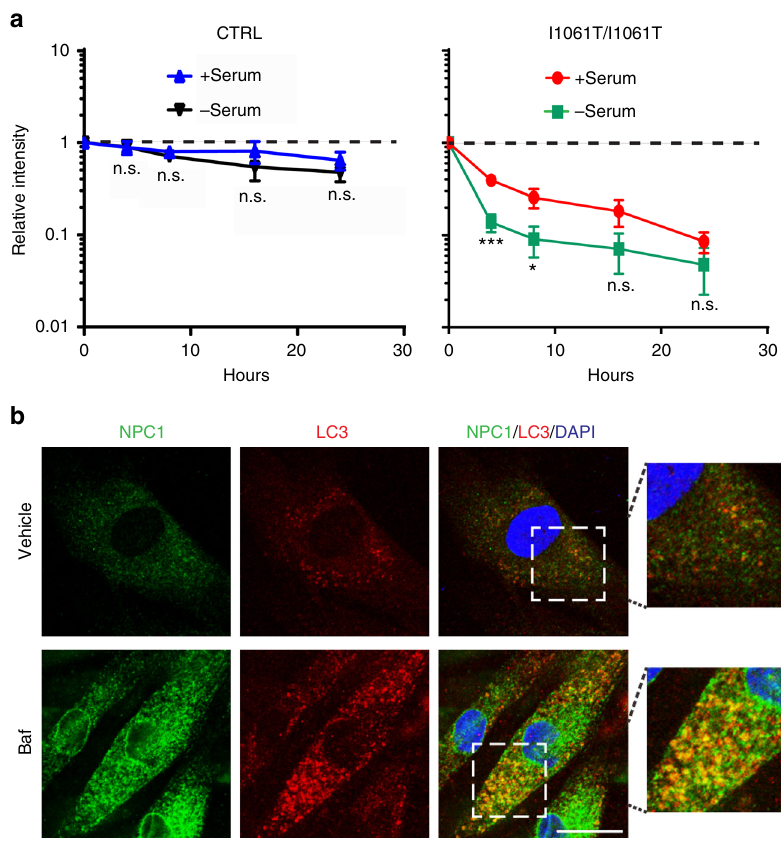
Fig. 4 I1061T NPC1 traf fi cs to autophagosomes. a CTRL or I1061T NPC1 primary human fi broblasts were treated with cycloheximide in the absence or presence of serum. Lysates were collected at indicated times and analyzed by western blot. b I1061T NPC1 fi broblasts were treated with vehicle or 100 nM ba fi lomycin A1 (Baf) for 24 h. Fixed cells were stained for LC3 (red), NPC1 (green), and DAPI (blue) then imaged by confocal microscopy. Co-localization is indicated by yellow color in the merged image. Scale bar = 25 μ m. Data are mean ± s.e.m. from three independent experiments. n.s., not signi fi cant, * P ≤ 0.05, *** P ≤ 0.001 by ANOVA with Bonferroni posthoc test (I10) F =